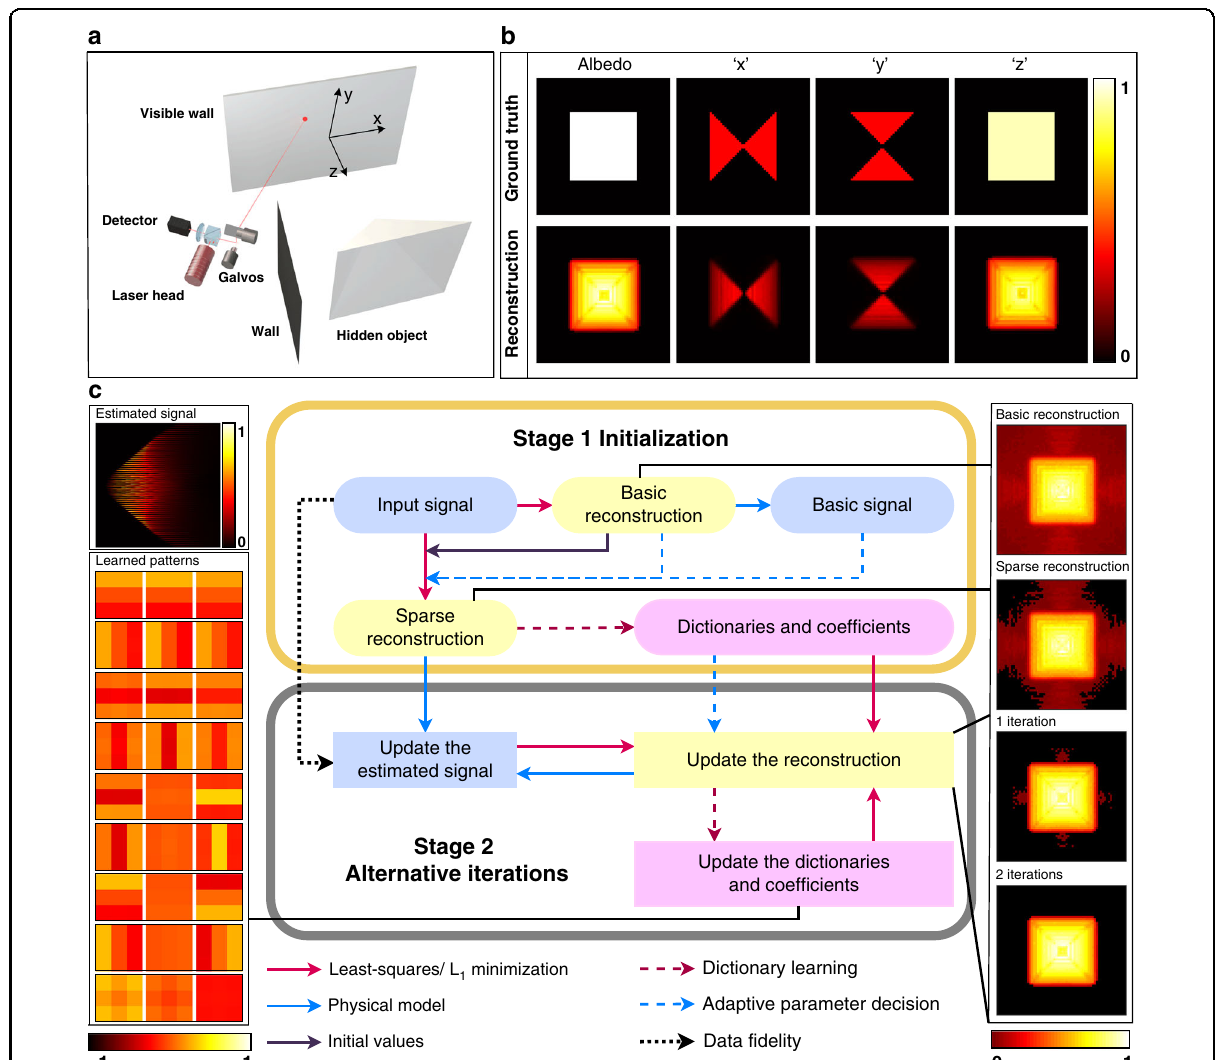
Fig. 1 Schematic of NLOS layout and the proposed SOCR reconstruction algorithm. a To reconstruct the unseen object, some light sources are used to illuminate a visible wall. The photons bounced back from the object are detected at several points on the visible wall. b Ground truth and our reconstruction. The x , y , and z components are displayed in their absolute values. c Flowchart of the proposed framework. The estimated signal and the learned patterns of the target are shown on the left. Reconstructed albedo is shown on the